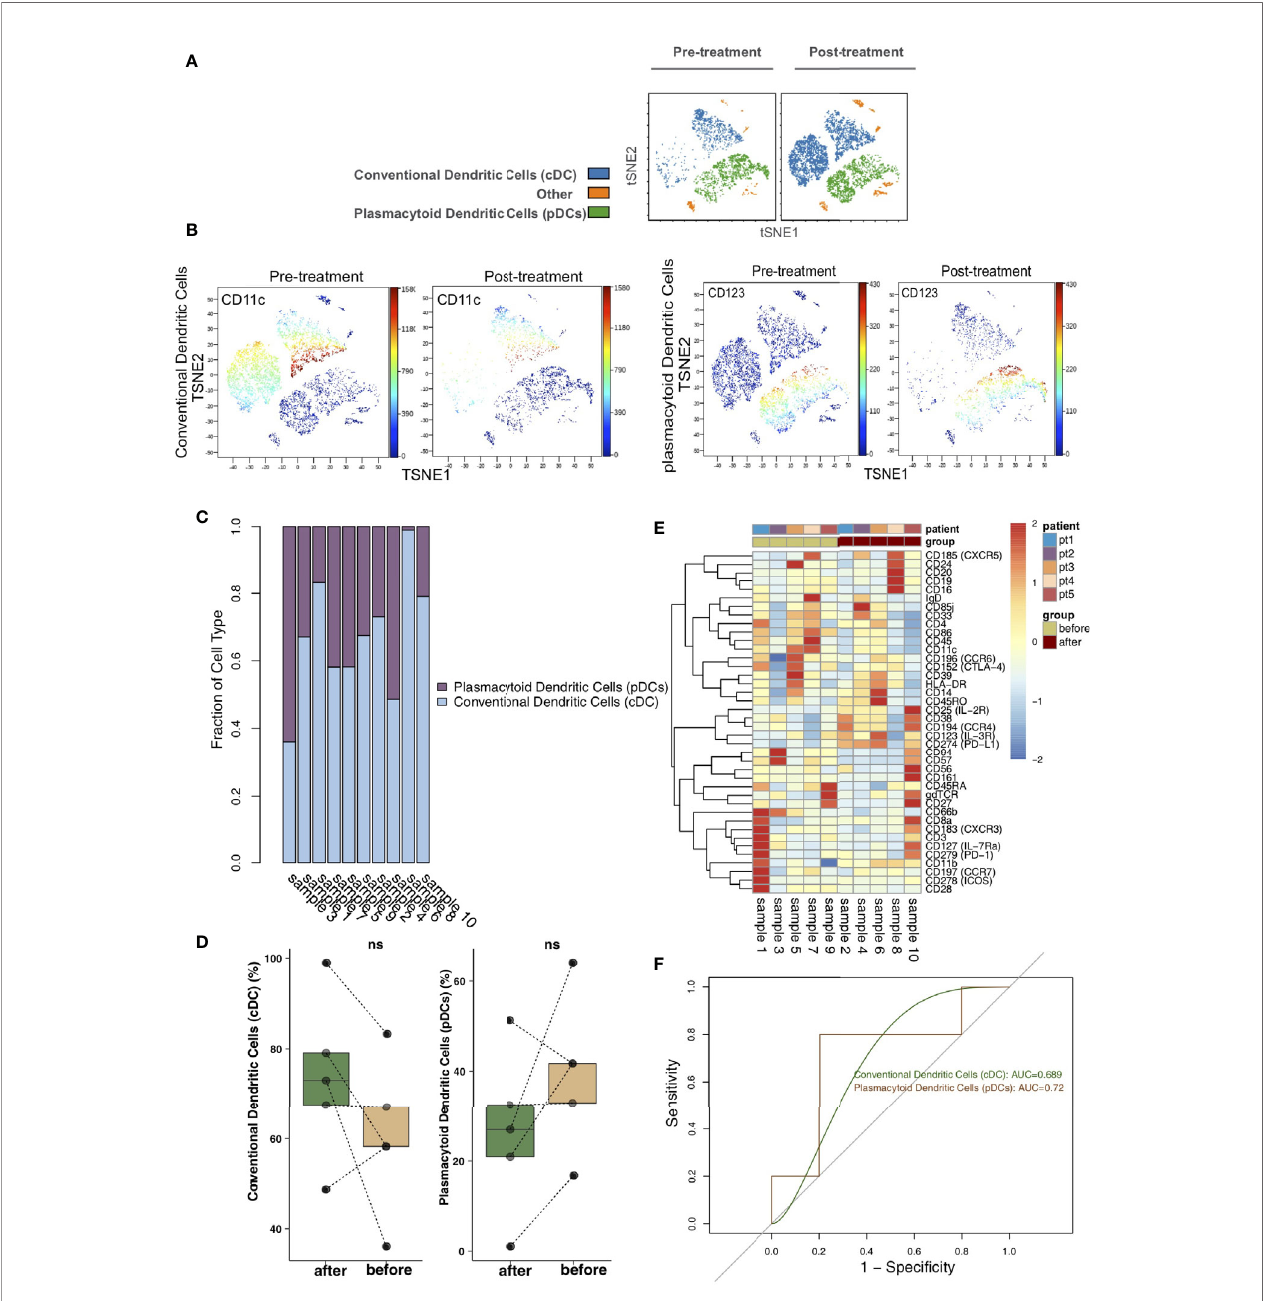
FIGURE 5 | Dendritic cell (DC) subclusters in the kidney. (A) t-SNE plots of conventional dendritic cells (cDCs) and plasmacytoid dendritic cells (pDCs). (B) t-SNE plots of CD11c and CD123 expression in the pre- and posttreatment groups. (C) The proportions of DC subclusters in all samples. (D) Comparison of the proportion of DC subclusters between the pre- and posttreatment groups. (E) Heatmap of the marker expression of DCs for all samples. (F) ROC curve of DC subclusters predicting the pre- and posttreatment groups. ns, not signi fi